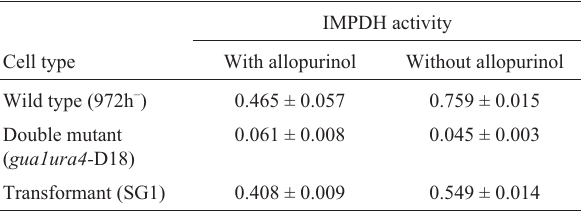
Table 1 - Inosine monophosphate dehydrogenase (IMPDH) activity (OD 340 permgpermlofprotein)incrudeextractsof Schizosaccharomyces pombe . Activity measurements were carried out using two different reaction mixtures, one with allopurinol (O’Gara et al ., 1997) and the other without allopurinol (Carr et al ., 1993). Values represent the average ± the standard deviation for three independent determinations.